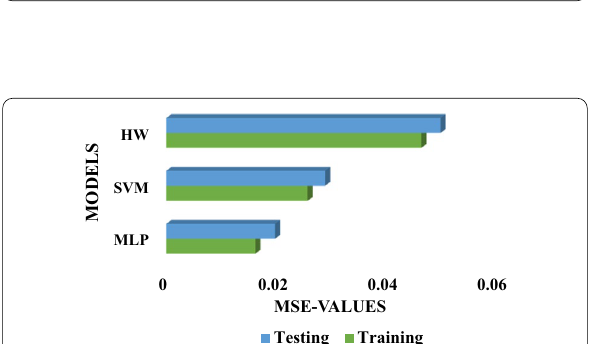
Fig. 5 Scatter plots of MLP, SVM, and HW models for the thyroidism status